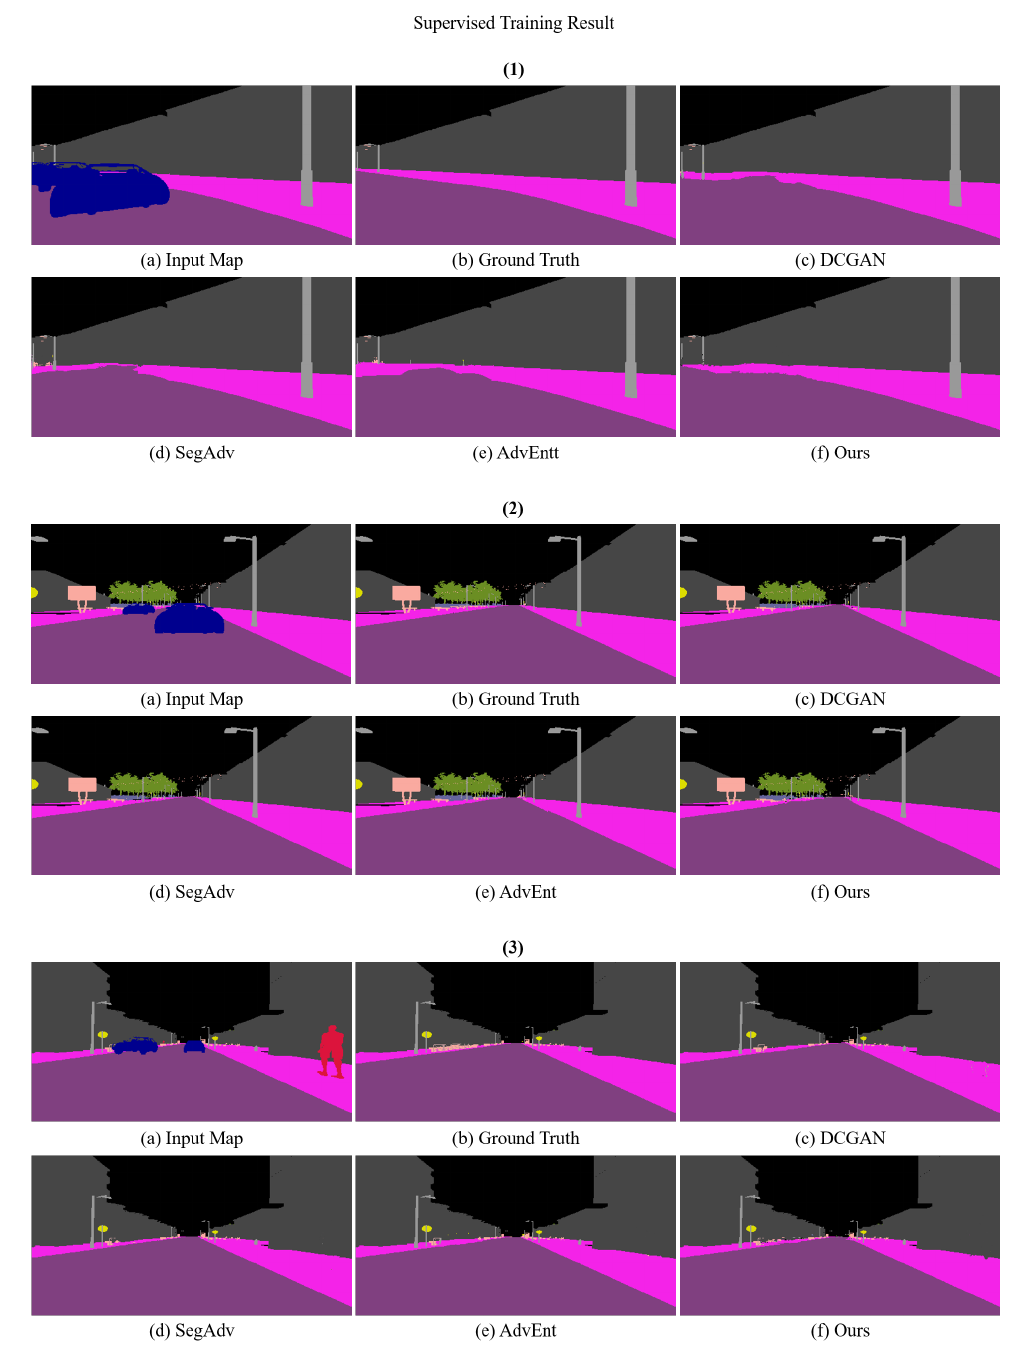
Figure 8. Supervised learning-based Media Integration and Communication Center Semantic Road In- painting (MICC-SRI) qualitative results: ( a ) input map, ( b ) ground truth, ( c ) deep convolutional gener- ative adversarial network (DCGAN) [20], ( d ) segmentation adversarial network (SegAdv) [29], ( e ) ad- versarial entropy network (AdvEnt) [27], and ( f ) semantic segmentation inpainting network